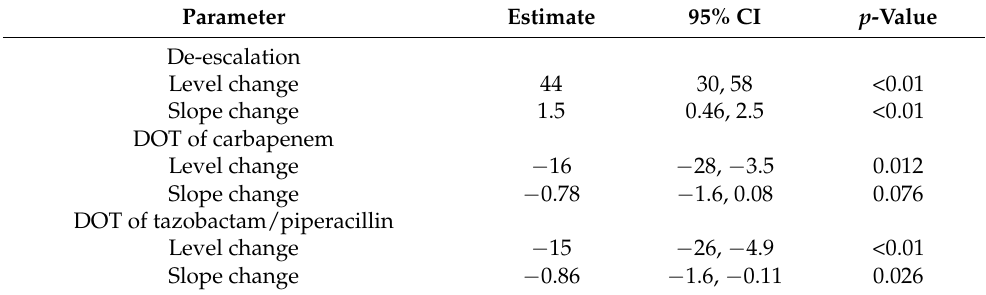
Table 3. Parameters of ITS analysis.